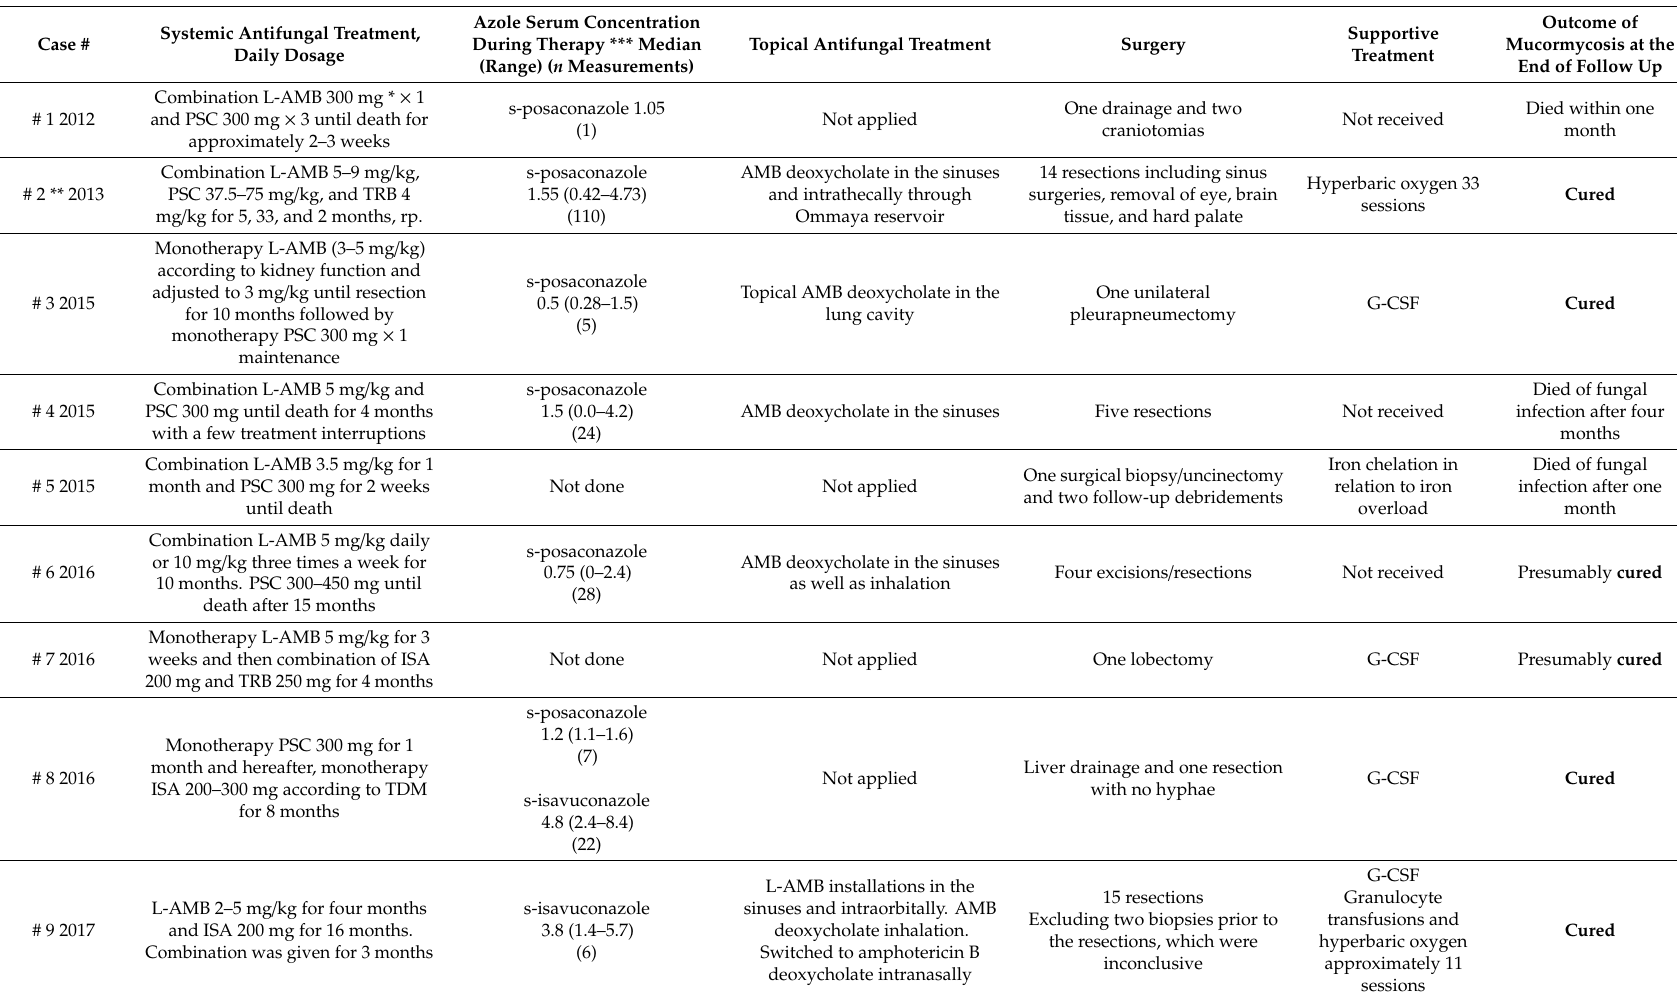
Table 4. Systemic, topical, surgical, and supportive therapy and mucormycosis outcome of 13 haematological